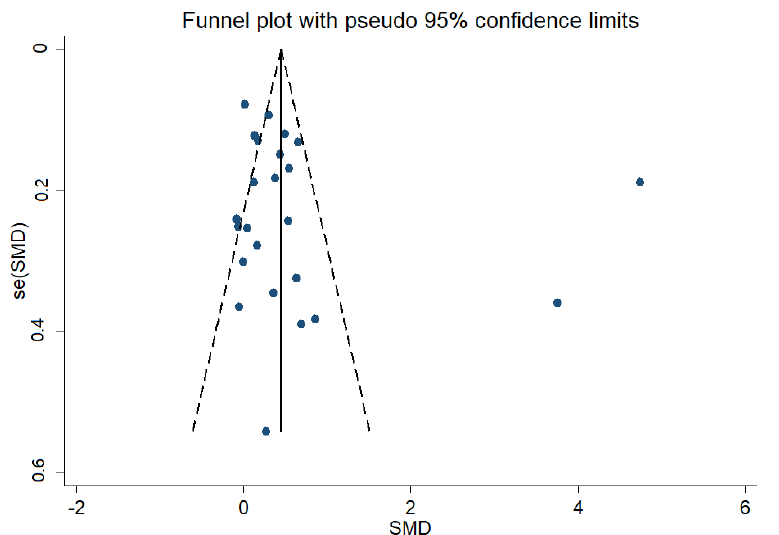
Figure 7. Funnel graph of publication bias of the association between PA and positive emotions in children and adolescents.